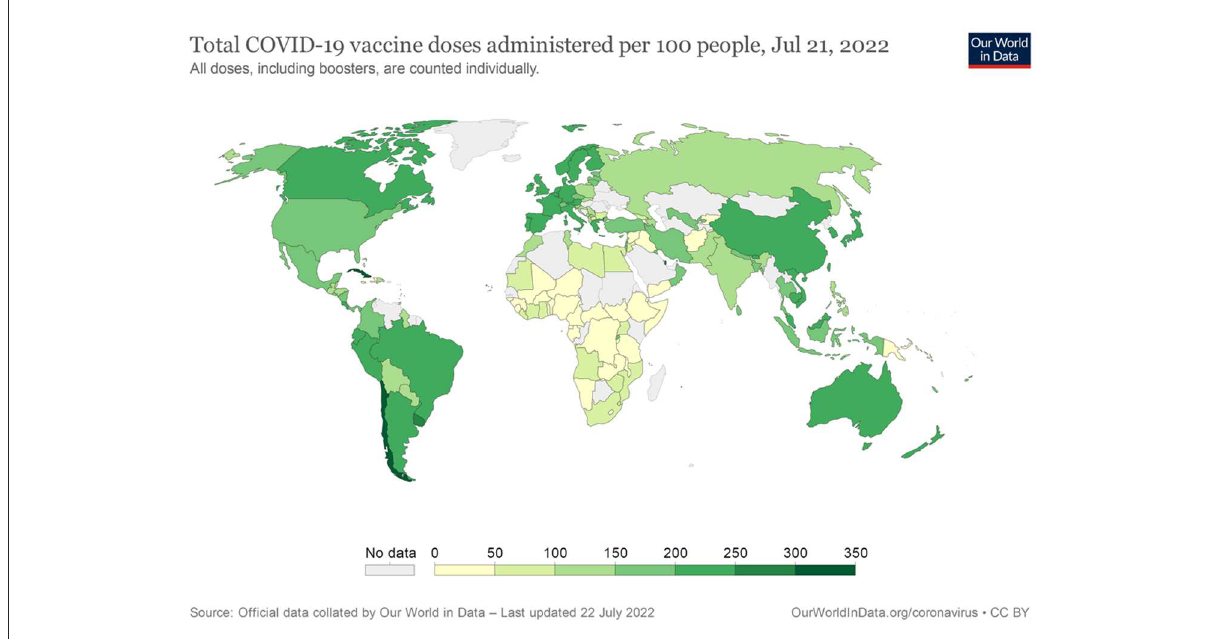
FIGURE1 The distribution of total number of people who have been fully vaccinated against